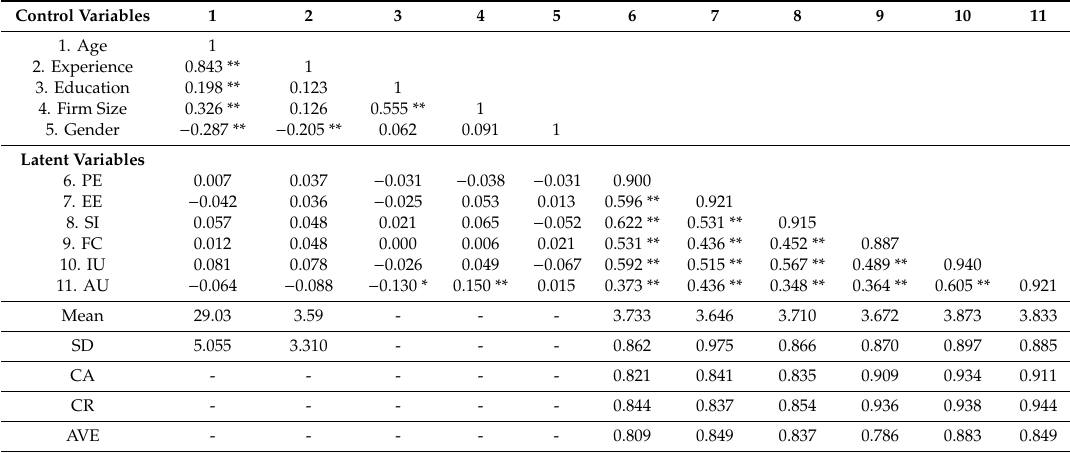
Table 1. Reliability, convergent, and discriminant validities test